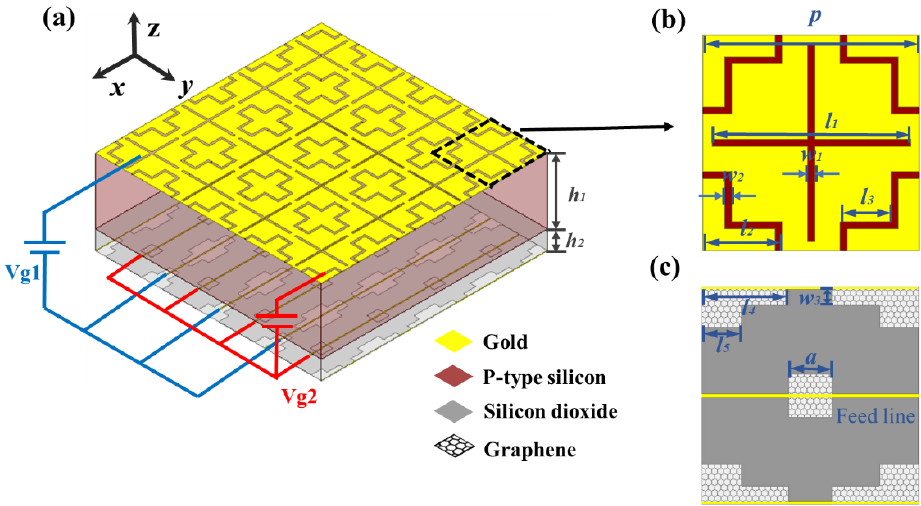
Fig. 1. Schematic diagram of (a) 3D view, (b) top view, and (c) bottom view of the proposed AFSS unit cell. The relevant geometrical dimensions are p=60, l 1 = 55, l 2 =22, l 3 =16, l 4 = 24, l 5 =11, w 1 =2, w 2 =2, w 3 =5, a =12, all in m m. The thicknesses of the p-type doped silicon, silicon dioxide substrates are h 1 = 3 m m, h 2 =0.3 m m,